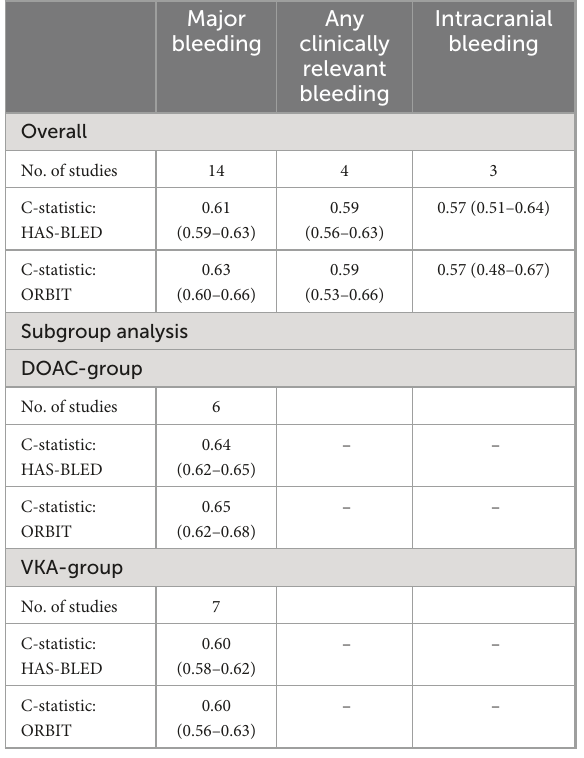
TABLE 2 C -statistics and 95% CIs between the HAS-BLED and ORBIT